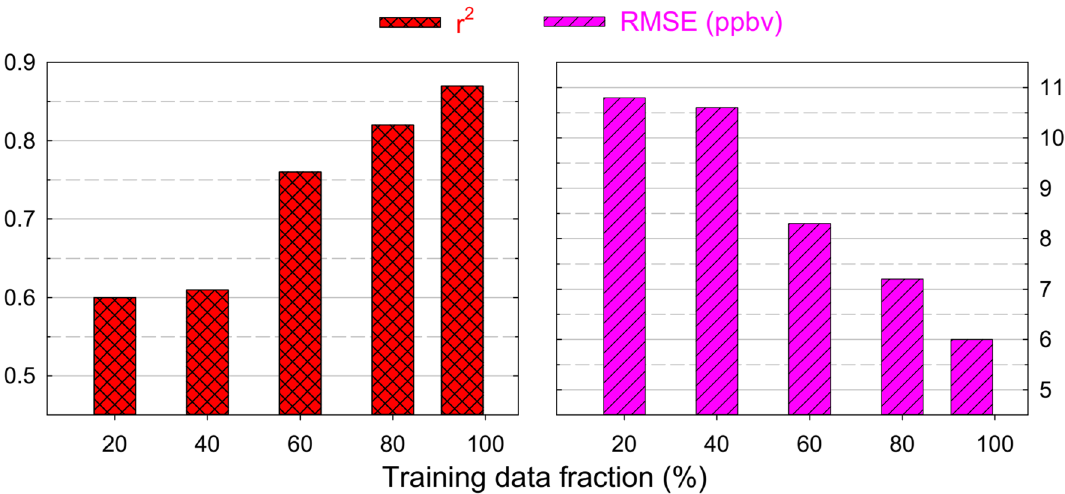
Figure 4. Variation in r 2 and RMSE with change in the percentage data used in training of ML